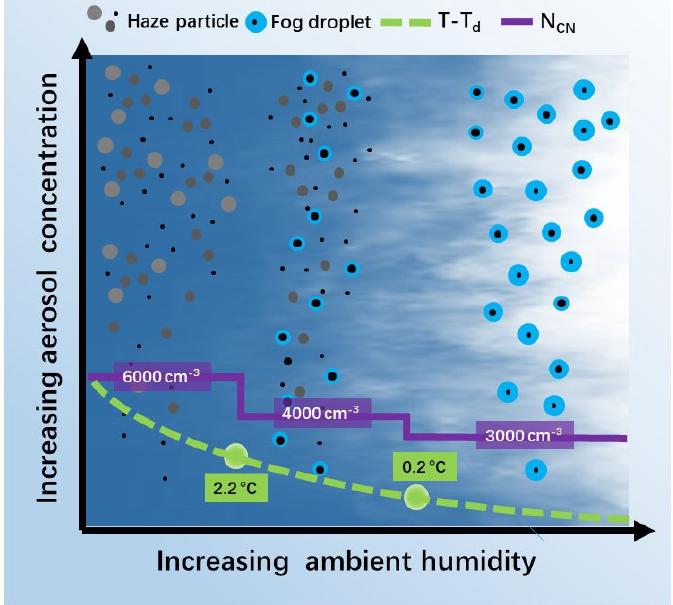
Figure 8. Conceptual model showing how the low-visibility events evolve with different meteorology and aerosol conditions.